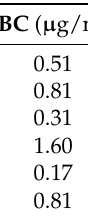
Table 1. eBC concentration during selected 52